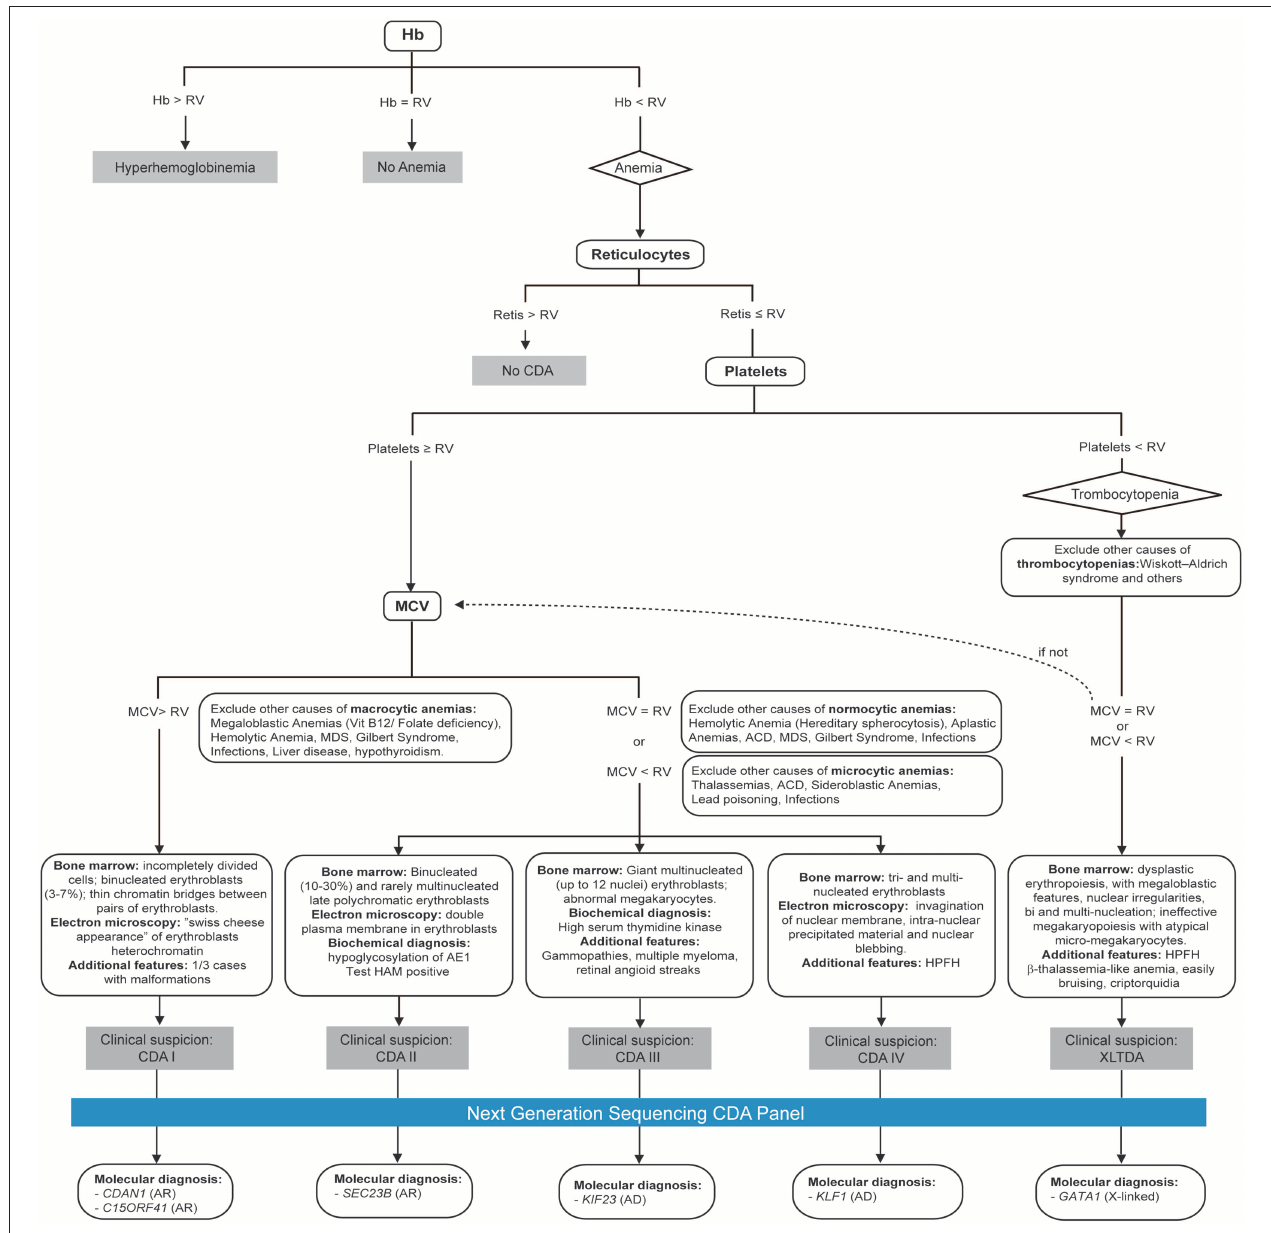
FIGURE 1 | Diagnostic algorithm used by the CoDysAn telemedicine tool. Hb, hemoglobin; RV, reference value; MCV, mean corpuscular volume; HPFH, hereditary persistence of fetal hemoglobin; AR, autosomal recessive; AD, autosomal